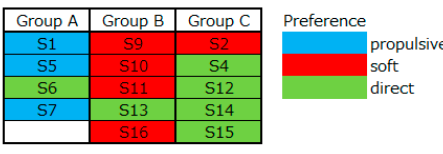
Figure 6. Relationship between shoe preference group and the group categorized by ankle EP